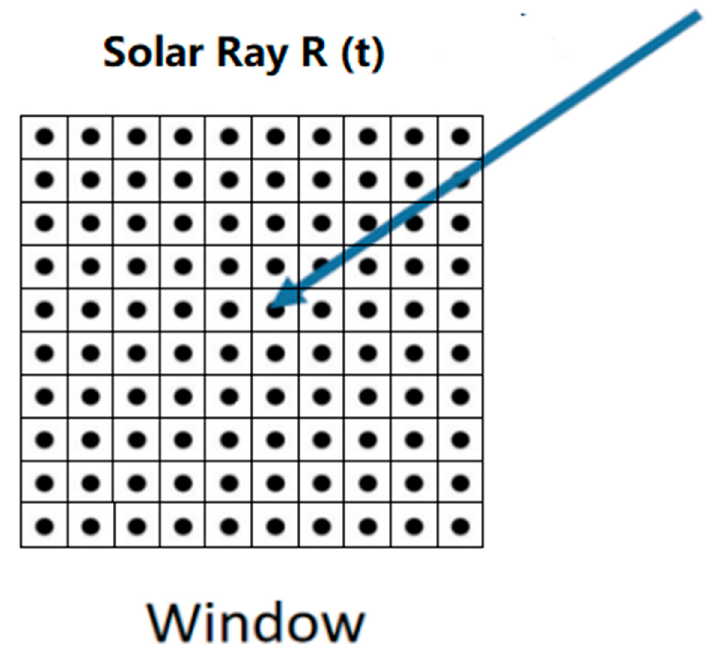
Figure 7. Finite element approach.